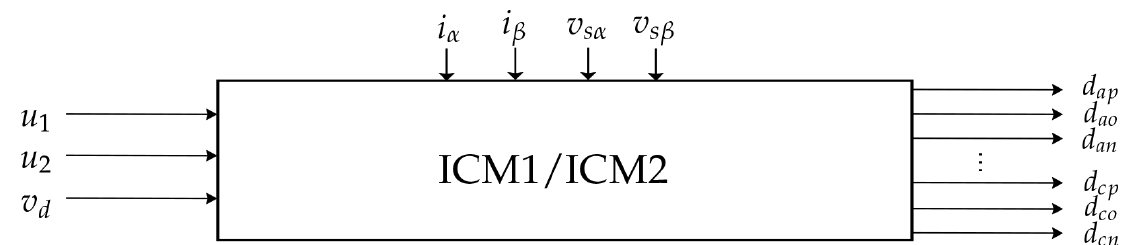
Figure 4. Data input and output of ICM1 and